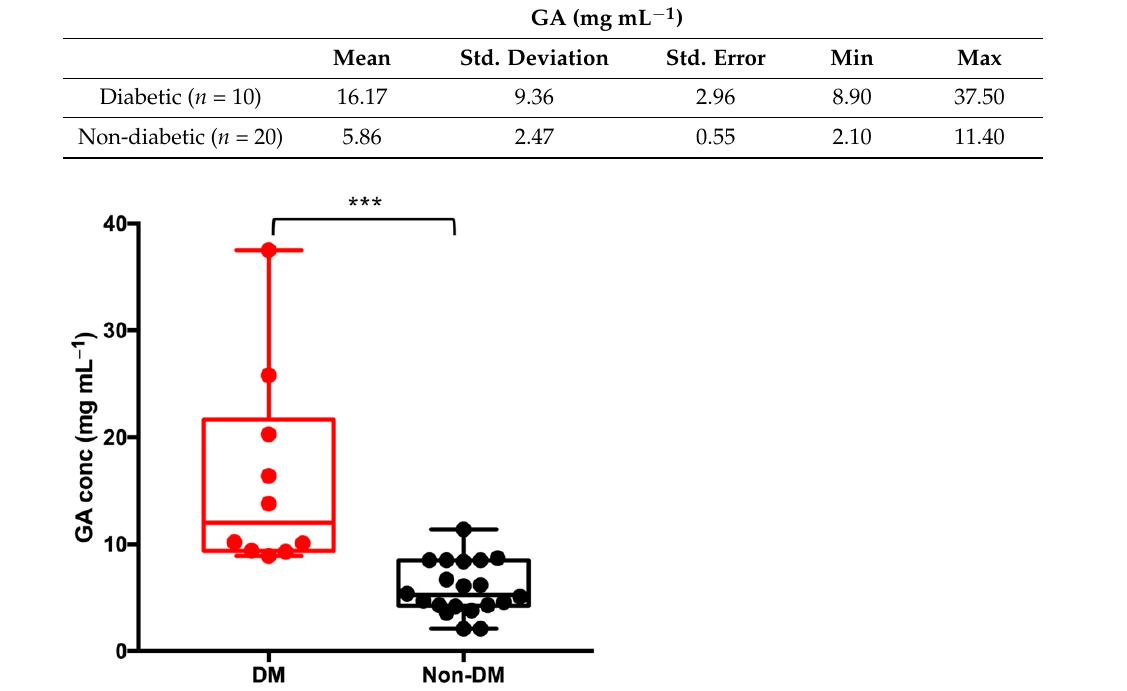
Figure 7. Statistical comparison of GA concentration (mg mL − 1 ) in DM and non-DM groups. The box plot shows statistically significant different GA levels between non-DM and DM groups (*** p < 0.001). Table 3. Descriptive statistics table showing different concentrations of GA in diabetic and non- diabetic sera.